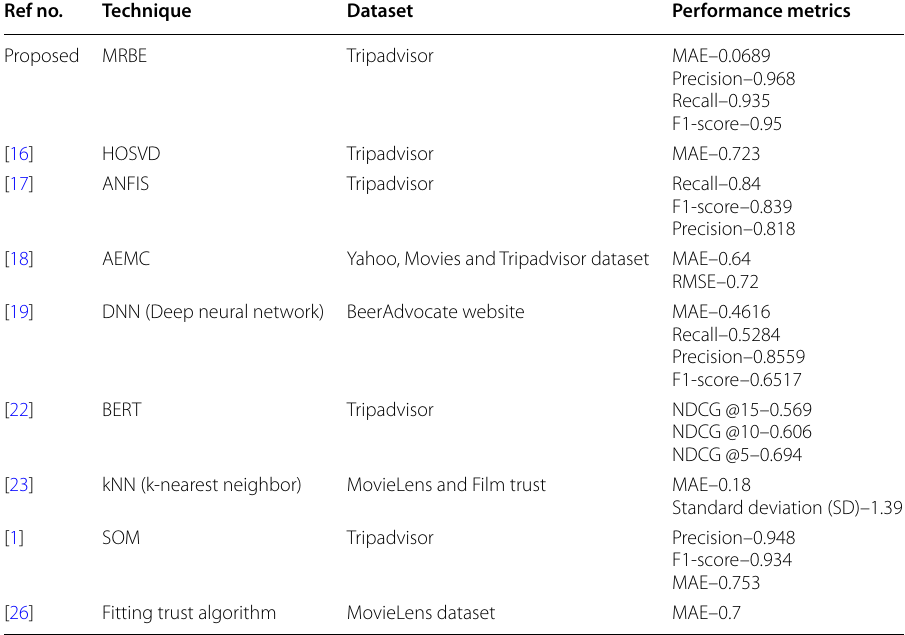
Table 13 Comparison between proposed and existing techniques Ref